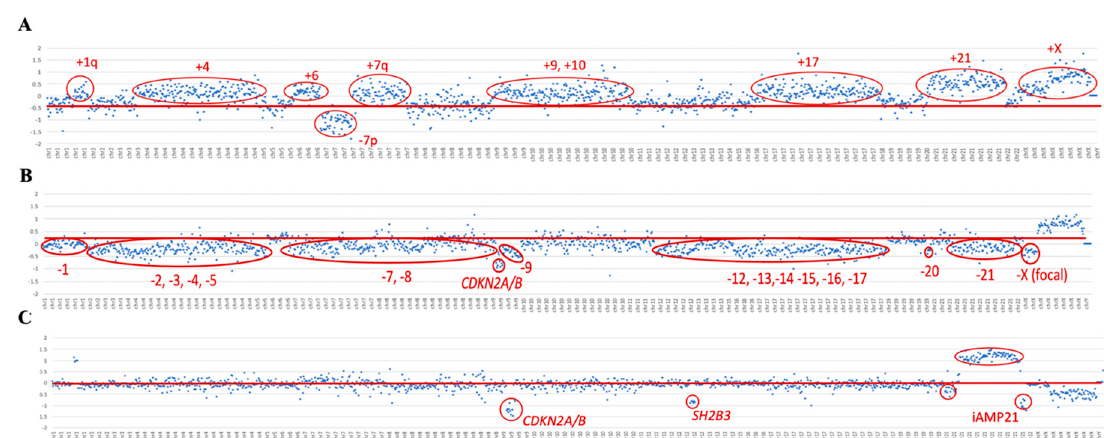
Figure 2. Dot plot of copy number variations (CNVs). This figure shows the dot plots of three samples for the detection of CNVs. The x-axis represents the chromosome regions included in the custom NGS panel, in increasing order from chromosome 1 to X. The y-axis shows the values of the log 2 ratio. The red lines indicate the reference, and in the red circles, there are the chromosomal regions above or below the reference, showing the respective gain or loss of that region. ( A ) Dot plot of the ID37 sample, showing a high hyperdiploid clone with the gain of chromosomes 1q, 4, 6, 7q, 9, 10, 17, 21, and X, in addition to the loss of 7p. ( B ) Dot plot of the ID43 sample, showing a near-haploid clone with the loss of chromosomes 1, 2, 3, 4, 5, 7, 8, 12, 13, 14, 15, 16, 17, 20, and 21. ( C ) Dot plot of the ID44 sample, showing the loss of the CDKN2A/B and SH2B3 genes, and of iAMP21.